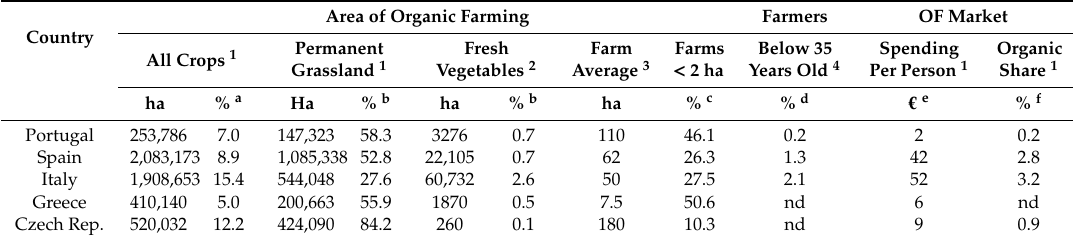
Table 6. Organic farming statistics of five European countries (Portugal, Spain, Italy, Greece, Czech Republic) regarding the cultivated area (all crops, permanent grassland, fresh vegetables); farm area; farmer’s age and